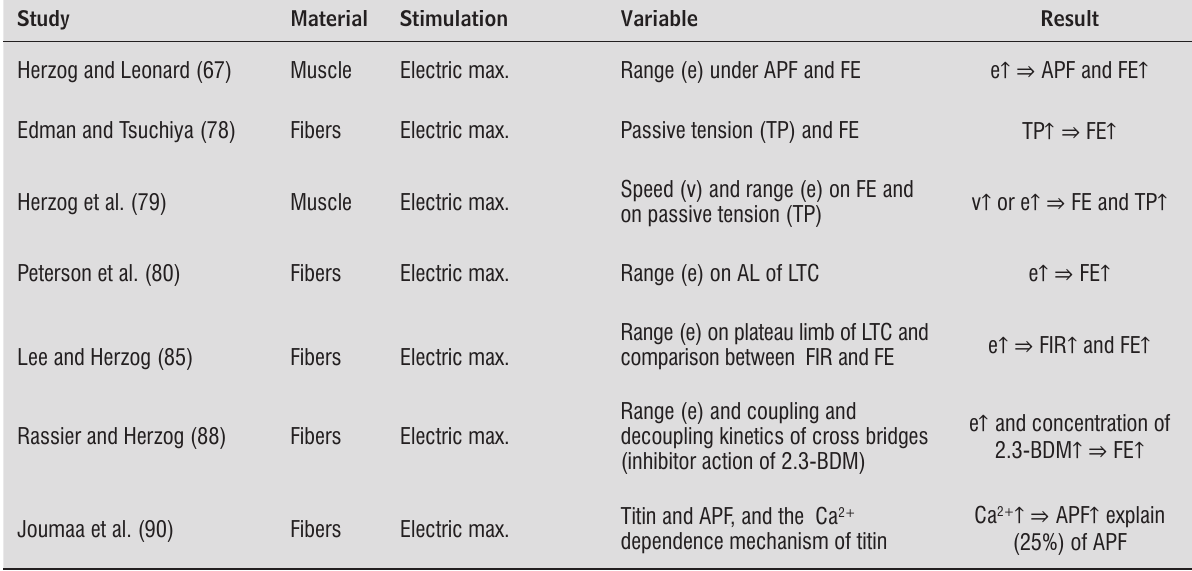
Table 2 - Main characteristics of the selected FE studies as on type of stimulation, the material used and the observed effects considering the characteristics of lengthening